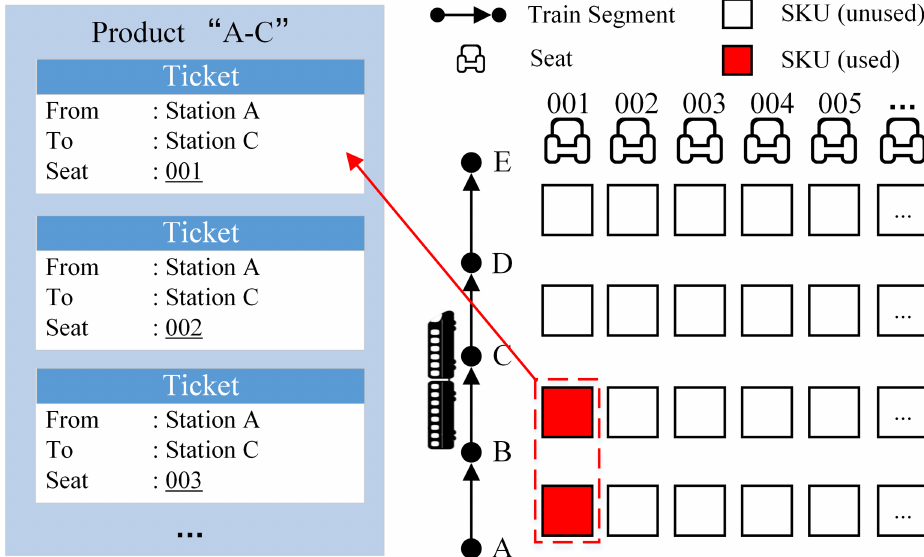
Fig 1. Basic Elements in the seat inventory control